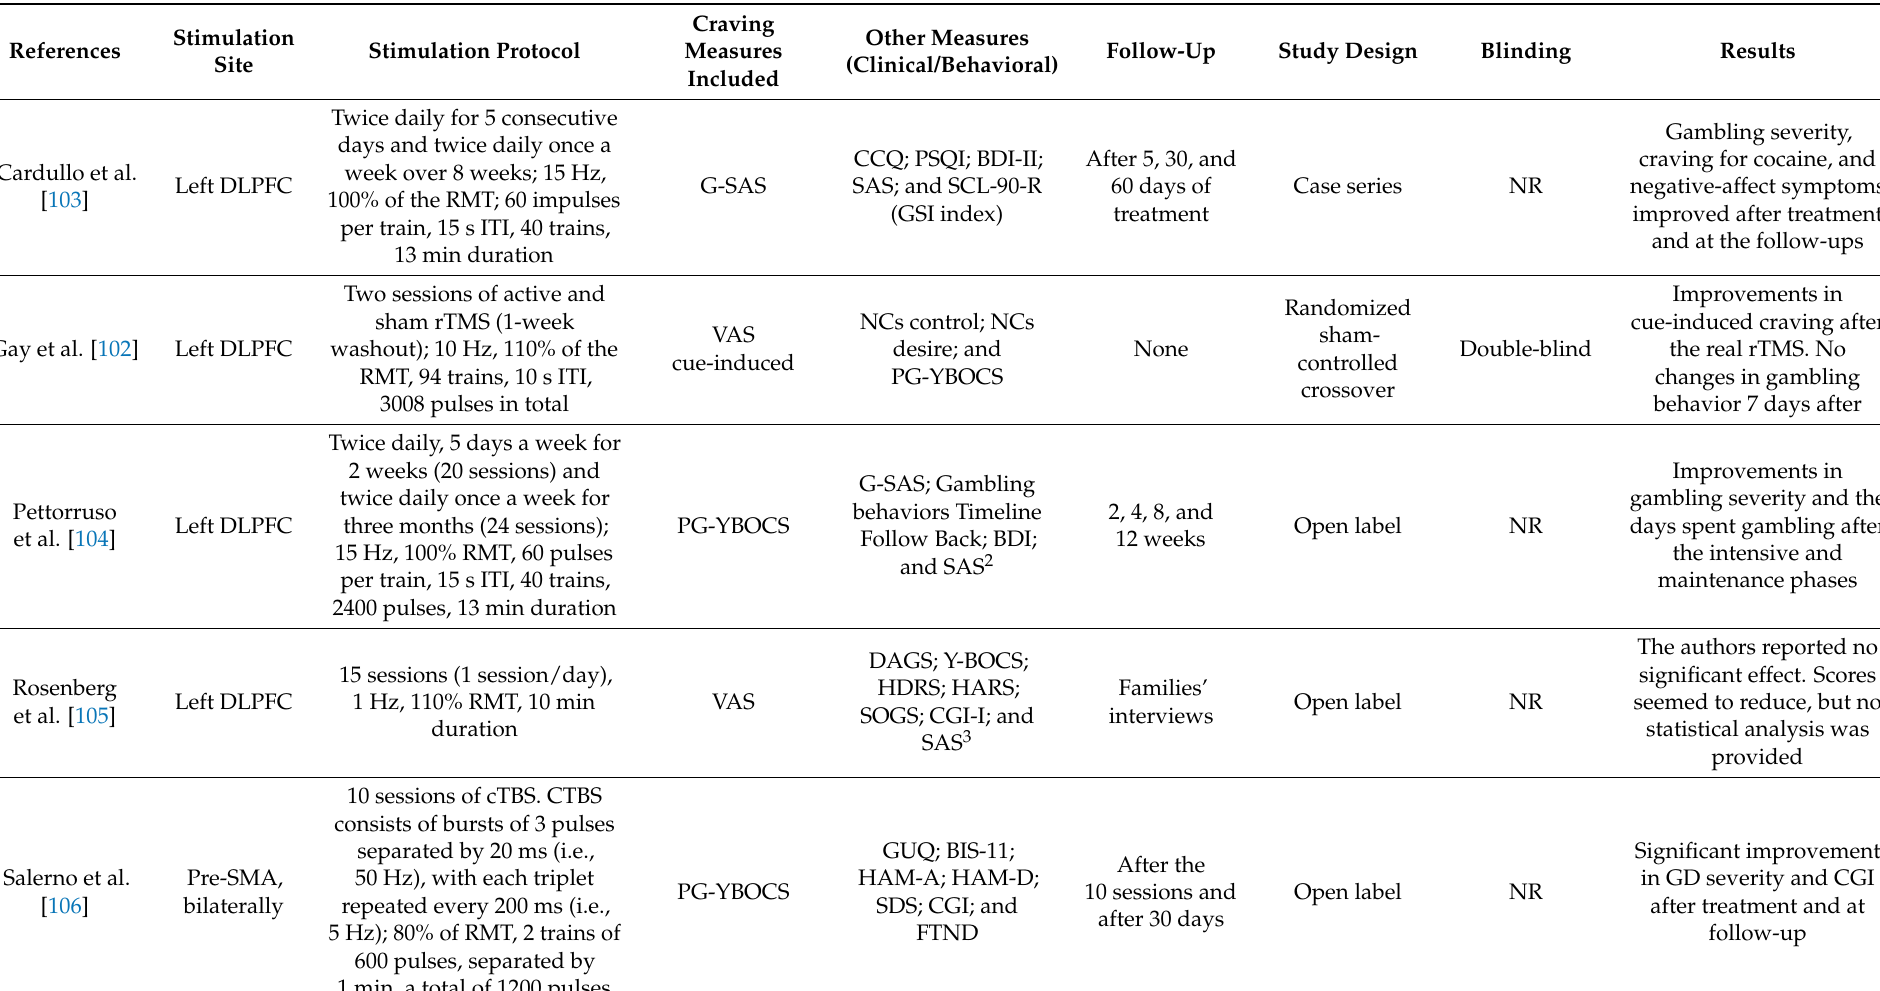
Table 5. Detailed information about TMS studies’ protocols and